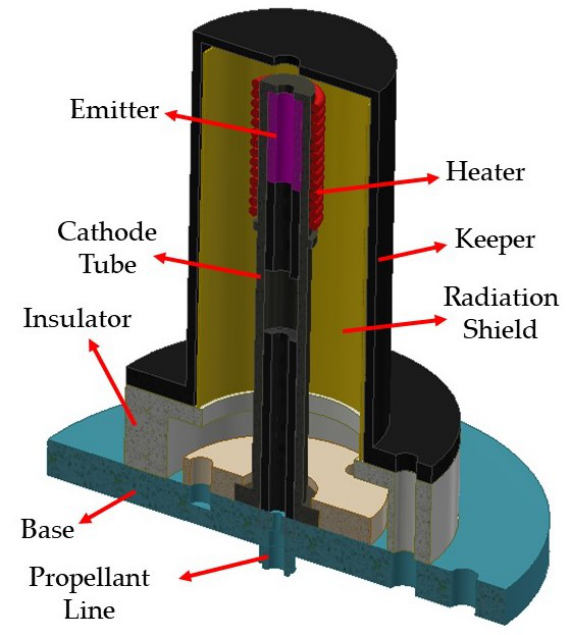
Figure 1. Schematic of a typical hollow